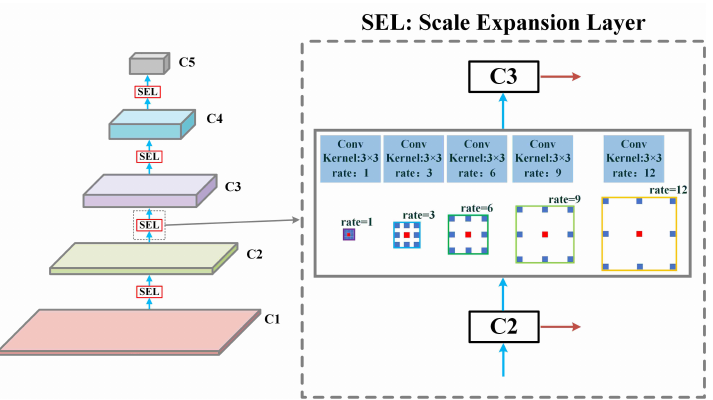
Figure 5. Architecture of dense-scale expansion layer. Different scale extension layers are placed in different network